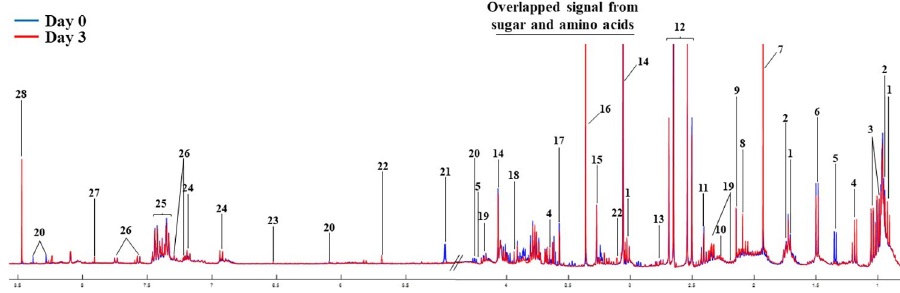
Fig 3. Representative median 1 H NMR CPMG spectra of SPMAP09 strain after crystallization in AU observed at initial point and 72 h. The full metabolite list is presented in Table